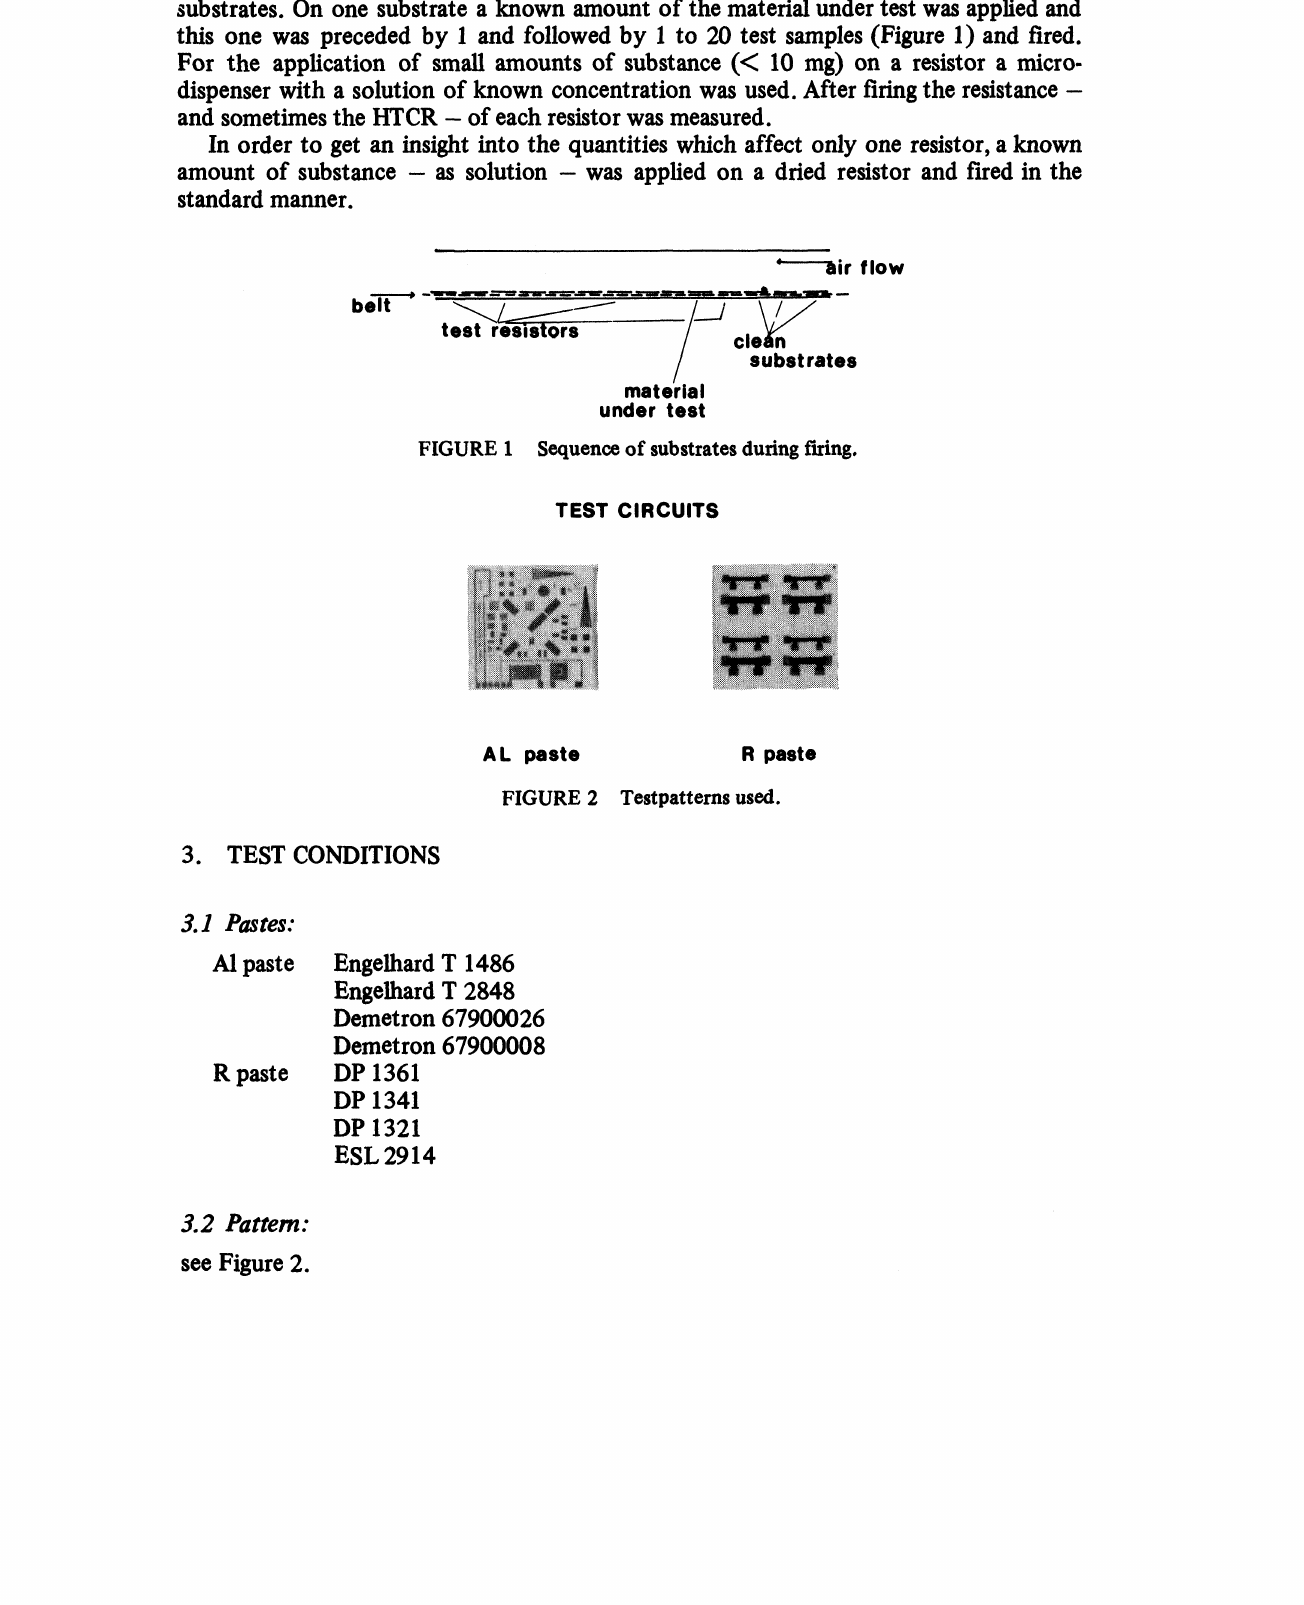
FIGURE 2 Testpatterns